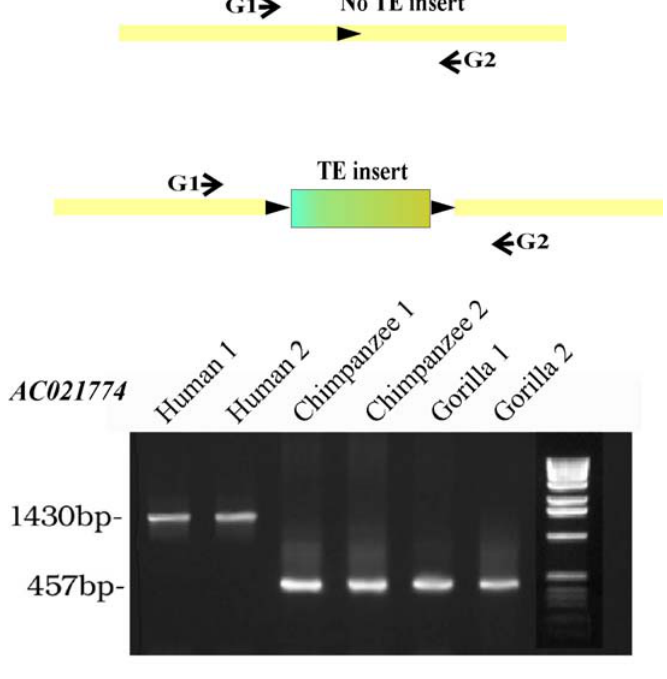
FIGURE 3. Schematic representation of the locus-specific PCR. Orthologous loci, which lack the TE insert, give shorter PCR fragments when amplified with TE-flanking unique genomic primers. This example illustrates locus- specific PCR of orthologous human and great ape genomic loci with primers, which flank the human HERV-K (HML-2) solitary LTR from genomic contig AC021774. Human amplification products are ~1 kb greater in size than the amplified loci from chimpanzee and gorilla DNAs, which suggests the presence of ~1-kb-long LTR in human genome and its absence from the apes’ orthologous